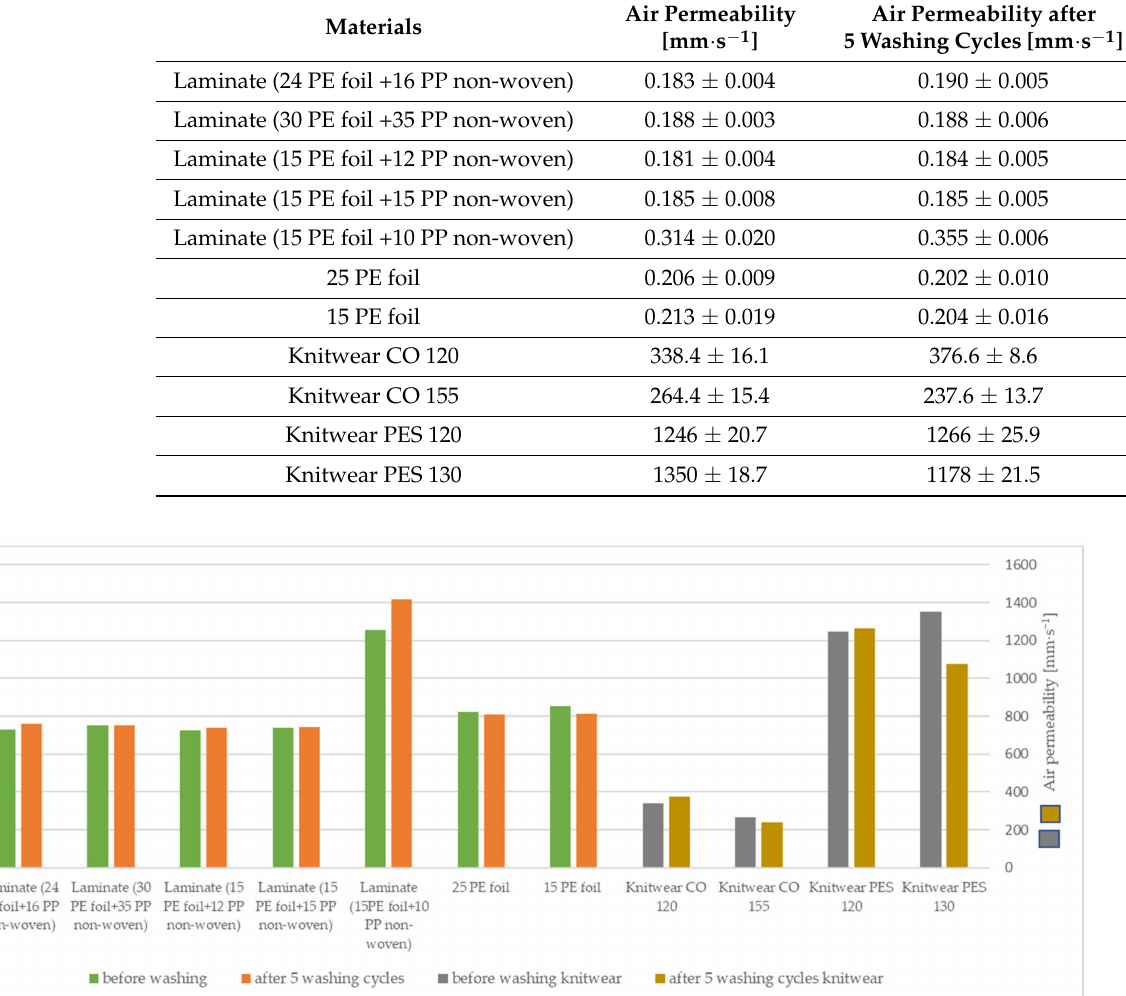
Table 5. Air permeability of tested materials.